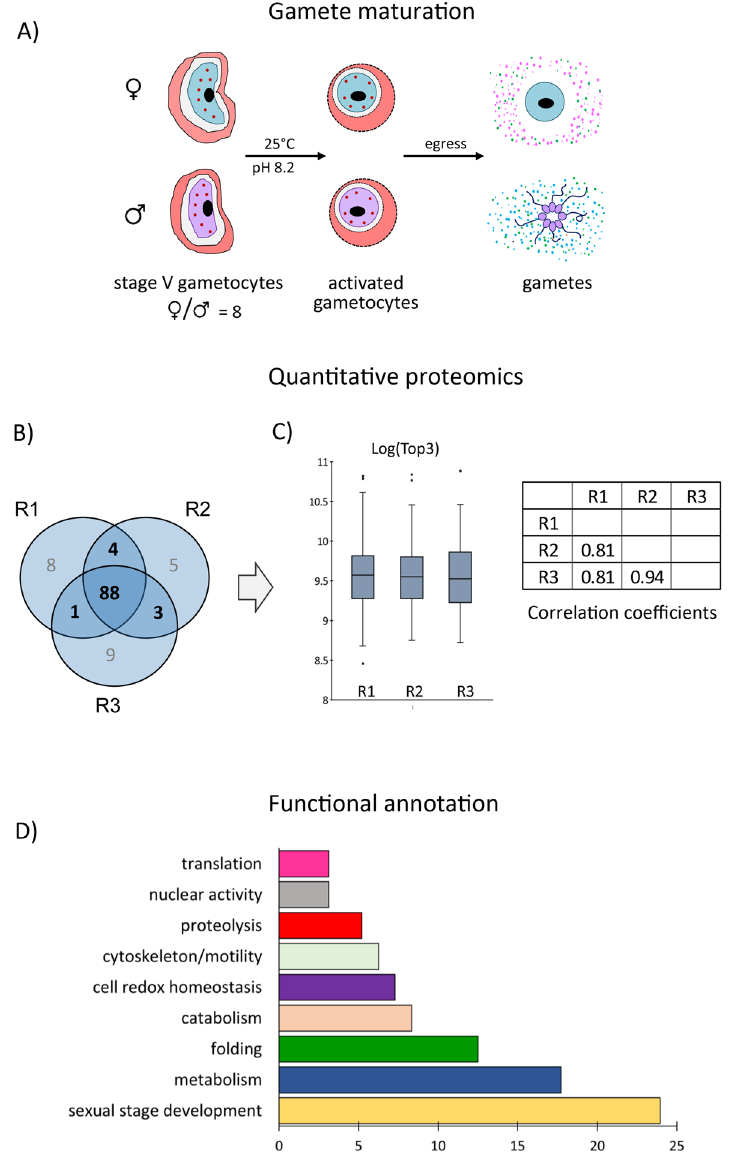
Figure 1. ( A ) Experimental design for characterization of proteins released by activated P. falciparum gametocytes. Enriched stage V gametocytes were induced to form gametes by a drop in temperature in induction medium. Culture supernatants were collected by centrifugation and proteins released during gametogenesis were aceton-precipitated and subjected to mass spectrometry analysis. ( B ) the overlap between the proteins identified by mass spectrometry in each technical replicate (R1–R3) is shown as a Venn diagram; ( C ) the reproducibility assessment of proteomic data is schematized. The distributions of Top3 values of proteins identified in 2 out of 3 replicates (R1–R3) are represented as box plots (T-test probabilities P = 0.94). Pearson’s correlation values calculated for each pair of replicates are reported in the Table (ANOVA P < 10–3). ( D ) Functional analysis based on GO annotations available in PlasmoDB is shown as a